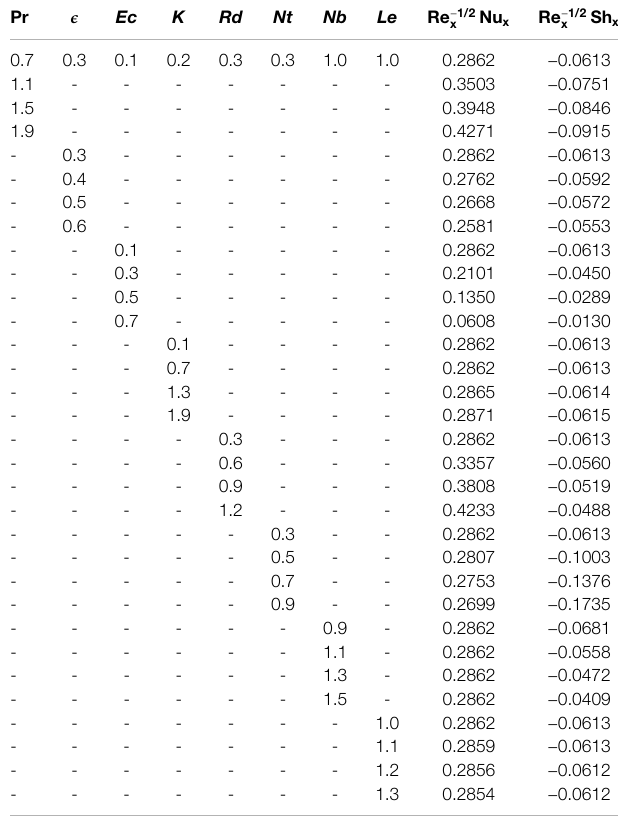
TABLE 4 | Numerical fi ndings of Sh x ( Re x ) − 0 . 5 and Nu x ( Re x ) − 0 . 5 for diverse values of